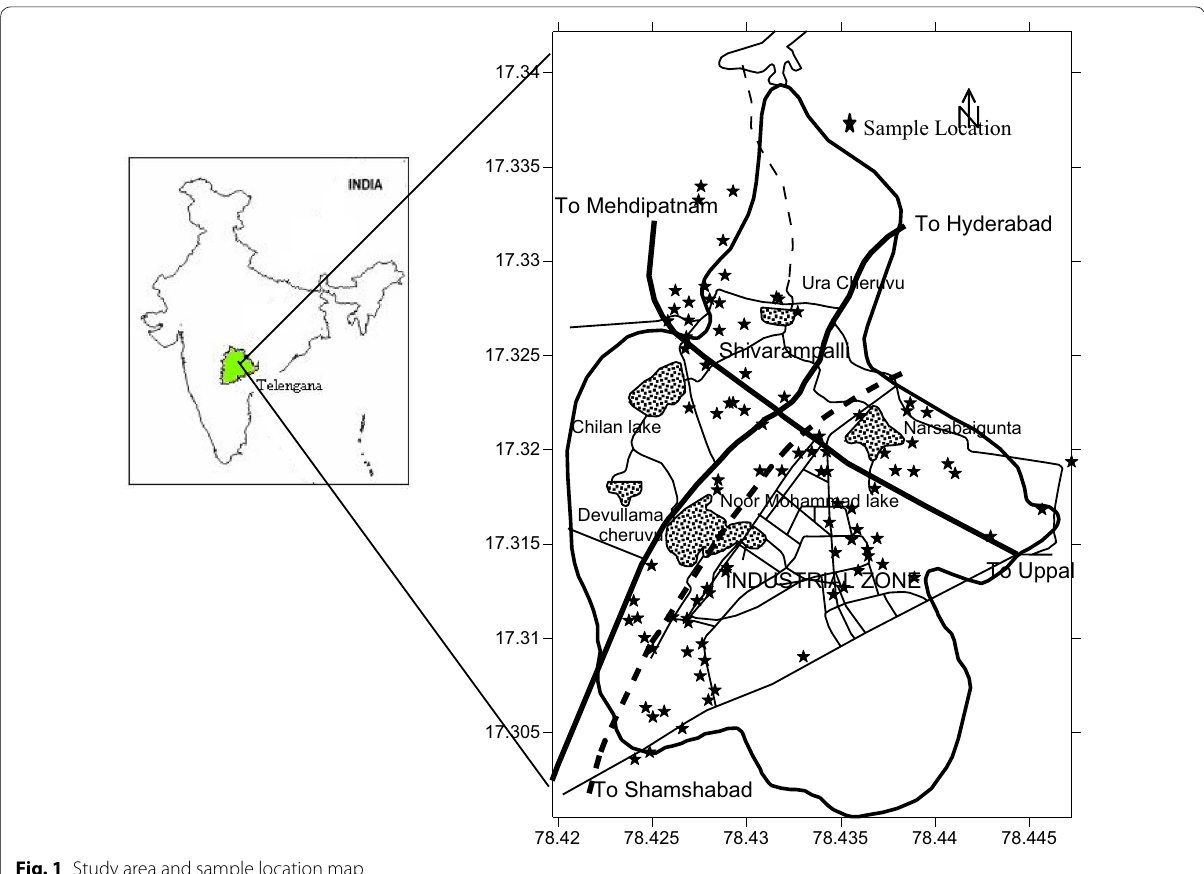
Fig. 1 Study area and sample location